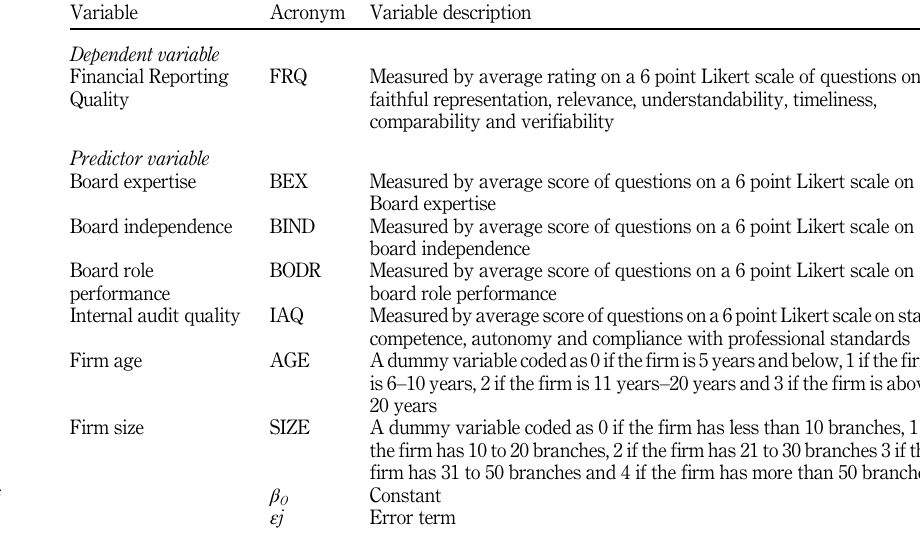
Table 2. Measurement of